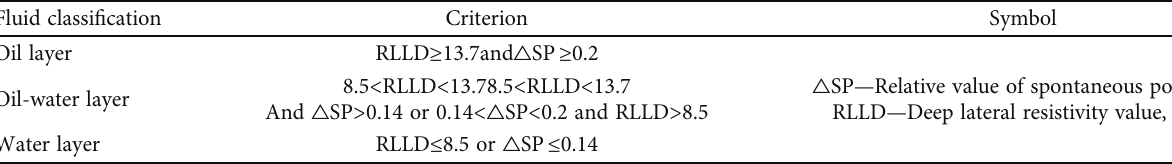
Table 2: Discrimination criteria.